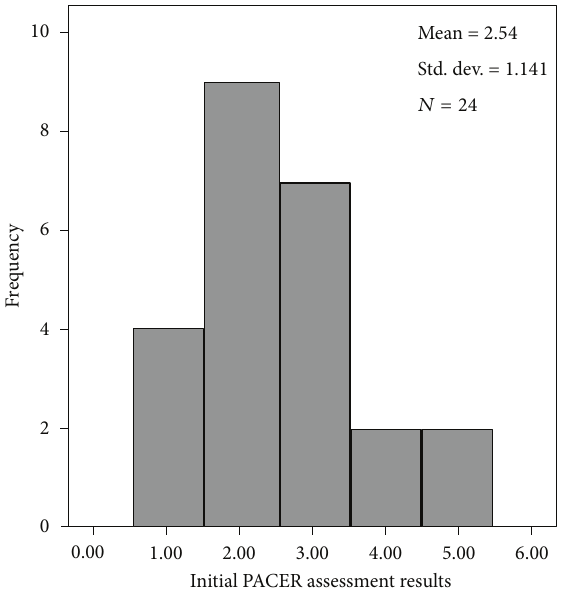
Figure2:Histogramoffinal20-meterPACERassessment.Frequen- cies are groups by 1 (1–10 laps), 2 (11–20 laps), 3 (21–30 laps), 4 (31–40 laps), and 5 (greater than 40 laps).